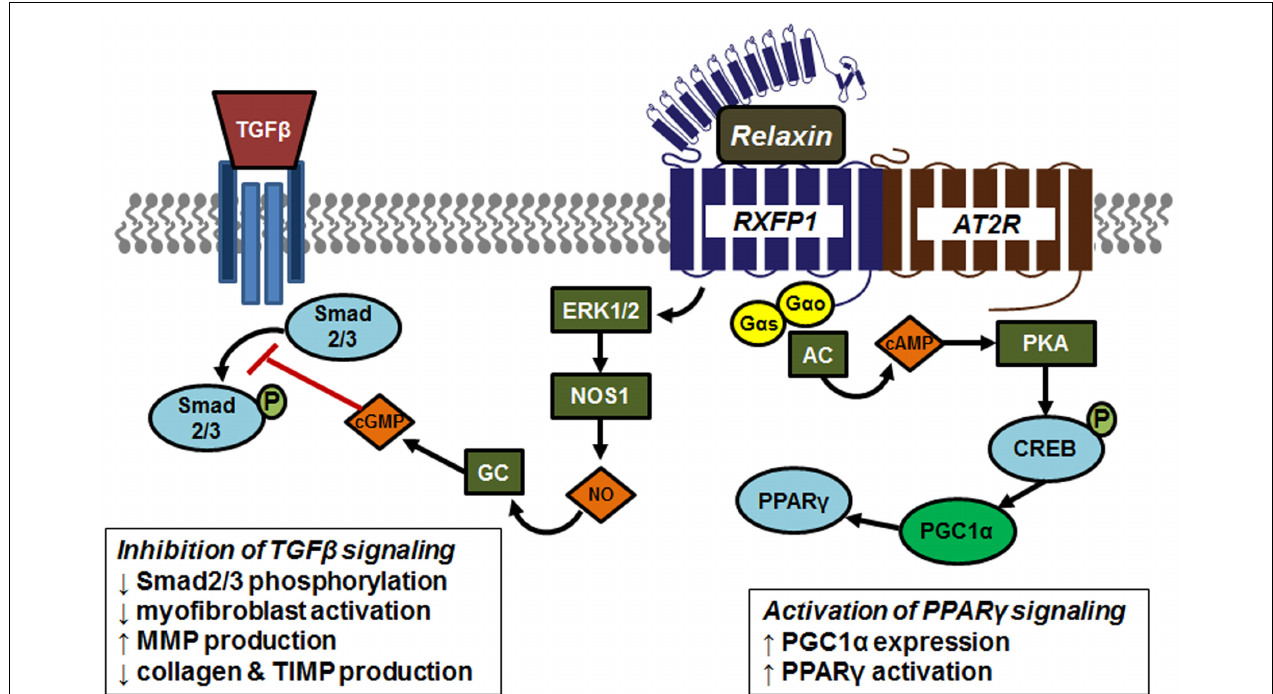
FIGURE 4 | Signaling and crosstalk associated with relaxin activation of its receptor RXFP1. The relaxin receptor RXFP1 can form heterodimers with the angiotensin II type 2 (AT2R), contribute to tissue-protective effects of relaxin. Relaxin antagonizes TGF β signaling through activation of the protein kinase ERK1, with downstream activation of endothelial nitric oxide synthase (NOS1) resulting in increased nitric oxide (NO) production. This in turn activates soluble guanylyl cyclase (GC) and cGMP production. This pathway inhibits phosphorylation of Smad2/3, resulting in decreased TGF β signaling. The RXFP1 signaling pathway also involves coupling to G α s to promote activation of adenylyl cyclase (AC), cAMP production and activation of protein kinase A (PKA). Activated PKA phosphorylates and activates the transcription factor cAMP response element binding protein (CREB) to induce expression of the coactivator protein PPAR γ coactivator 1 α (PGC1 α ), which serves to increase PPAR γ